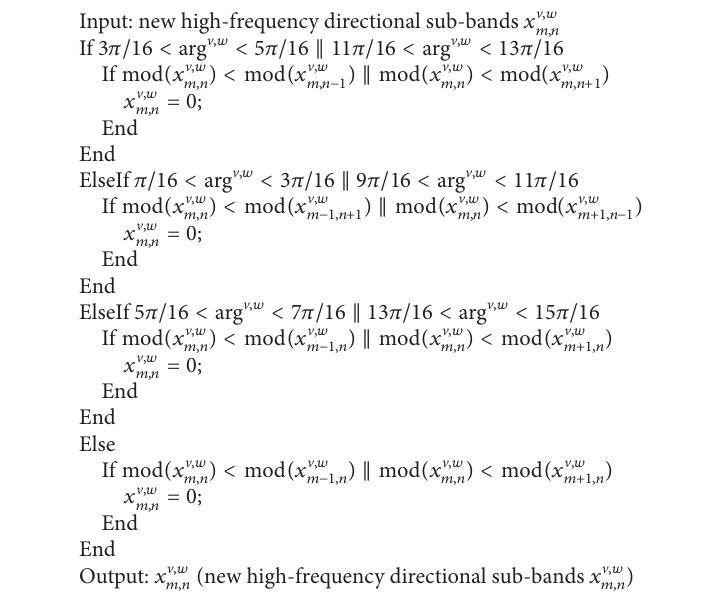
Algorithm 2: Local mold maxima suppression algorithm.